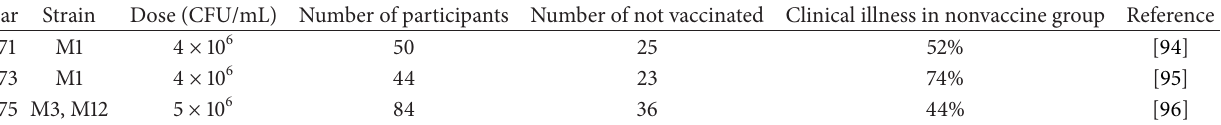
Table 4: Previous GAS human challenge studies. CFU/mL: colony-forming units per